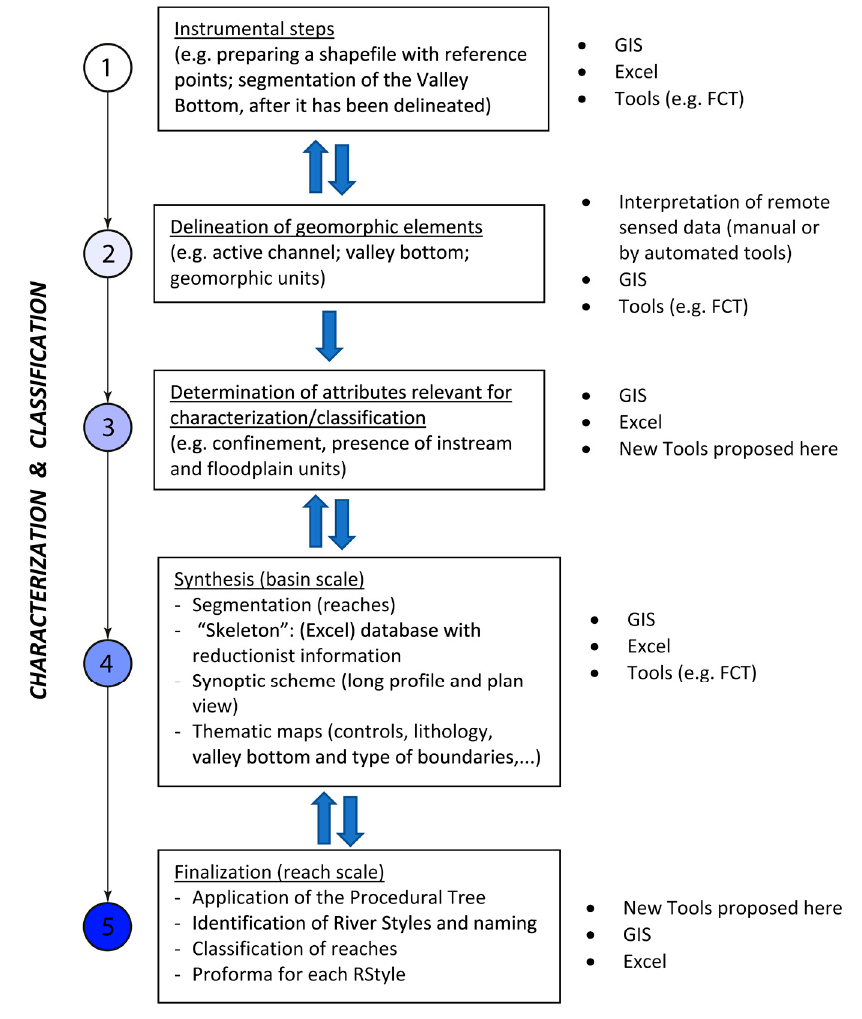
Figure 1. Scheme of the whole procedure proposed for the River Styles inspired characterization and classification of rivers within a basin (the Procedural Tree is the structured set of attributes adopted in the River Styles Framework (RS) analysis to characterize river reaches; Proforma is the standardized document adopted again in the RS analysis to described in a more detailed fashion each particular River Style found. Additional details are provided in Appendix A). FCT = Fluvial Corridor ToolBox.